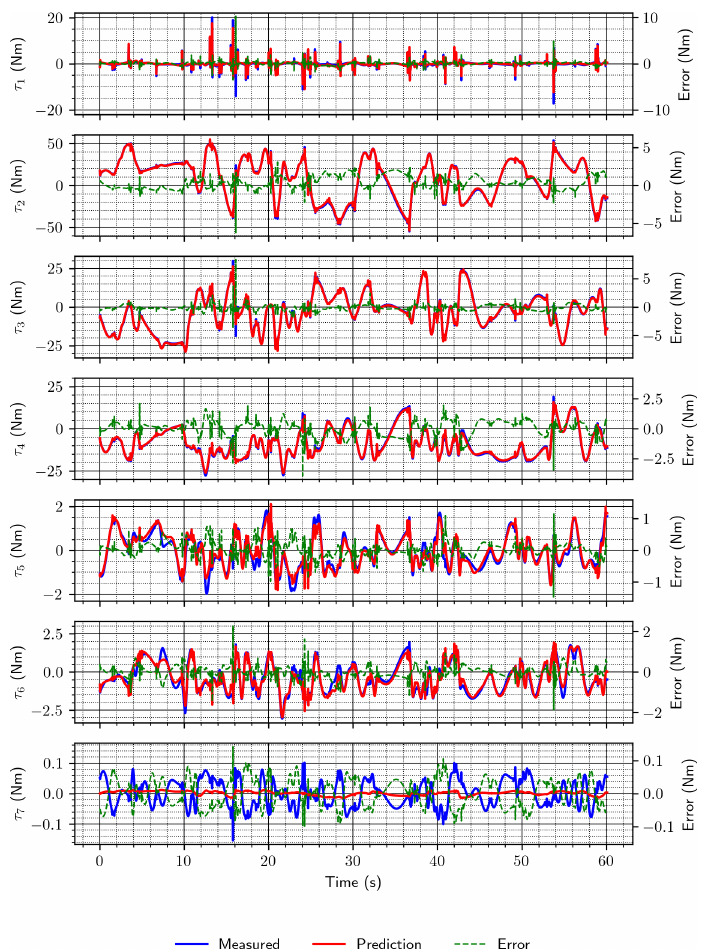
Figure 11. Example joint torque estimates for optimized LSTM